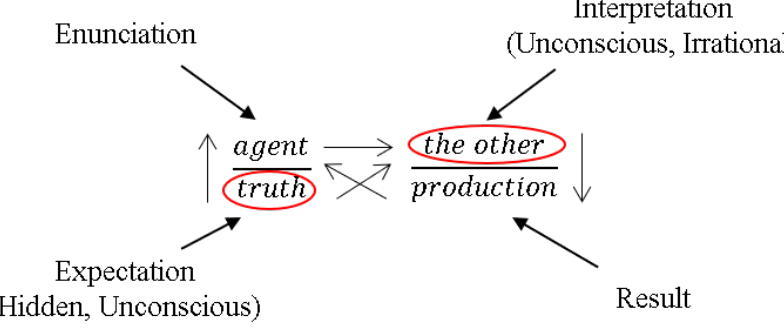
Figure 7. The four places of the discourse: the “agent”, the giver of the discourse; the “other”, the one to whom the discourse is addressed; under the message of the agent is hidden the “truth”, which is masked by the official statement; and hidden under the other is the “production”, or what the agent gets out of the